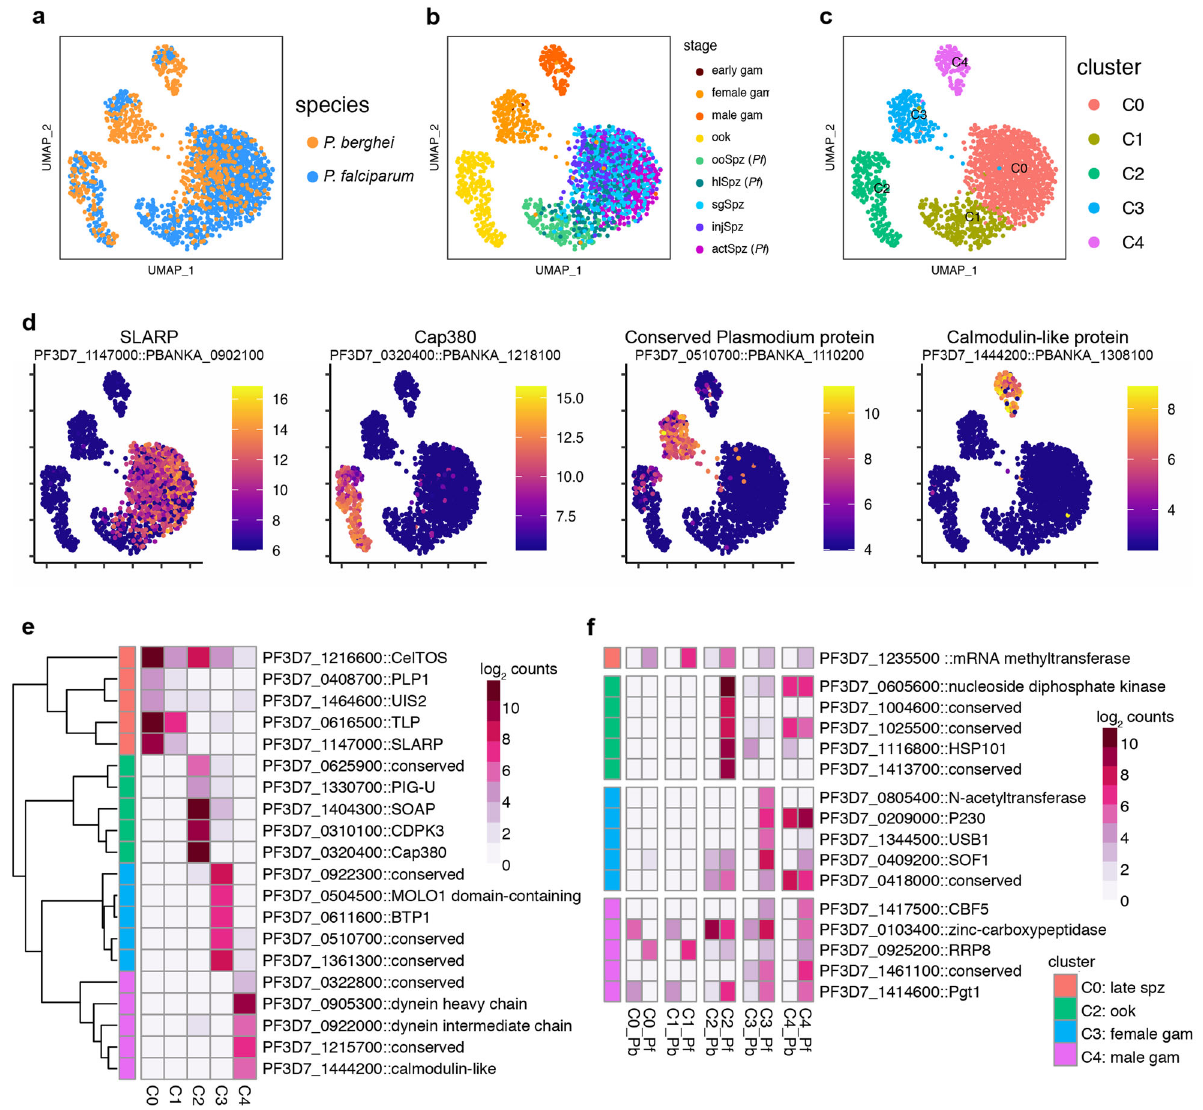
Fig. 2 Integration of P. falciparum and P. berghei transmission data sets. To identify conserved and divergent patterns of gene expression P. falciparum single-cell data was integrated with the P. berghei transmission stage data using one-to-one orthologs. a – c UMAP of integrated data colored by species ( a ), collection stage ( b ), and cluster assignment ( c ). Collection stages that were not included in the P. berghei data set are marked in legend with ( Pf ) in ( b ). Cluster C1 was not included in further differential expression analysis because it was composed primarily of P. falciparum oocyst and hemolymph sporozoites. We observed that cells clustered by cell types that were shared across the two data sets. P. falciparum gametocytes appeared more tightly clustered compared to P. berghei , within the gametocyte clusters, likely owing to differences in sample sizes for these stages (Pb female: 127, Pb male: 74, Pf female: 52, Pf male: 33). d Expression (log 2 counts) of the top-conserved marker gene, based on the lowest maximum p value (Wilcoxon rank-sum test) across the two species, for clusters 0 (SLARP), 2 (Cap380), 3 (conserved Plasmodium protein PF3D7_0510700), and 4 (calmodulin-like protein) on the UMAP. e Heatmap of the top fi ve conserved marker genes based on Bonferroni-adjusted p value (Wilcoxon rank-sum test) across the two species, for each cluster. The expression values represent the mean log counts for each cluster. f A heatmap of the top one-to-one orthologs that are more highly expressed in P. falciparum ( Pf ) compared with P. berghei ( Pb ) (based on adjusted p value and expression in at least 70% of P. falciparum cells). The expression values represent the mean log counts for each species in each cluster. Heatmaps are annotated with the P. falciparum gene identi fi er for the ortholog and manual annotation. Genes annotated as conserved are conserved proteins with unknown function in Plasmodium